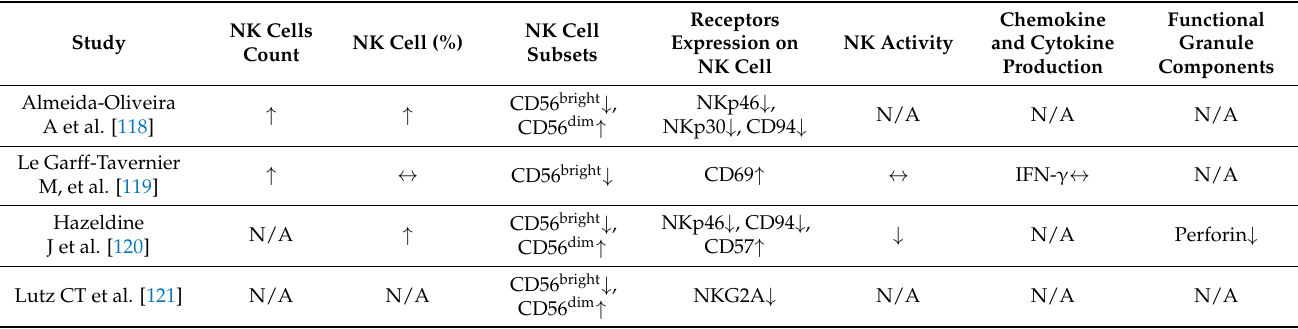
Table 2. Overview of Aging Associated Alterations of Human NK Cells.